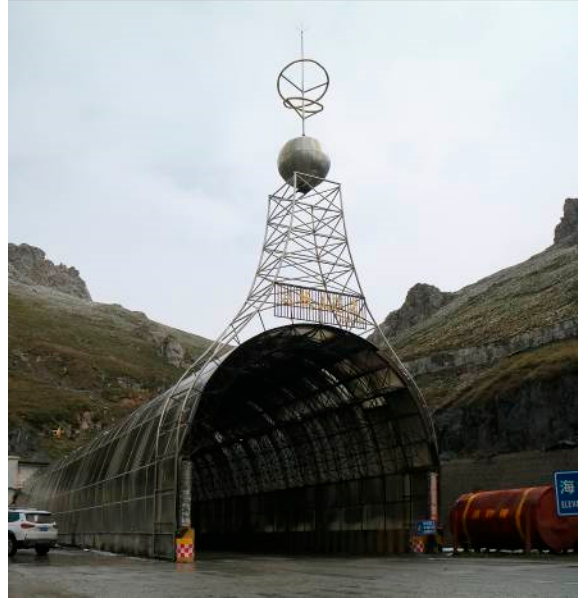
Figure 5. Thermal insulation gate at the entrance of Yuximolegai tunnel (photographed by Y.F Zhou).